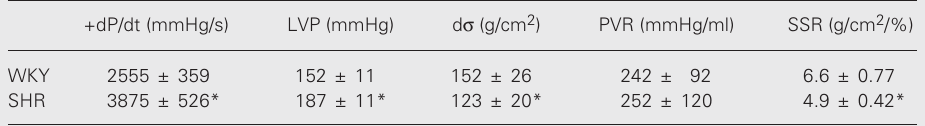
Table 2. Isolated heart systolic function indexes in a chronic pressure-overload model.